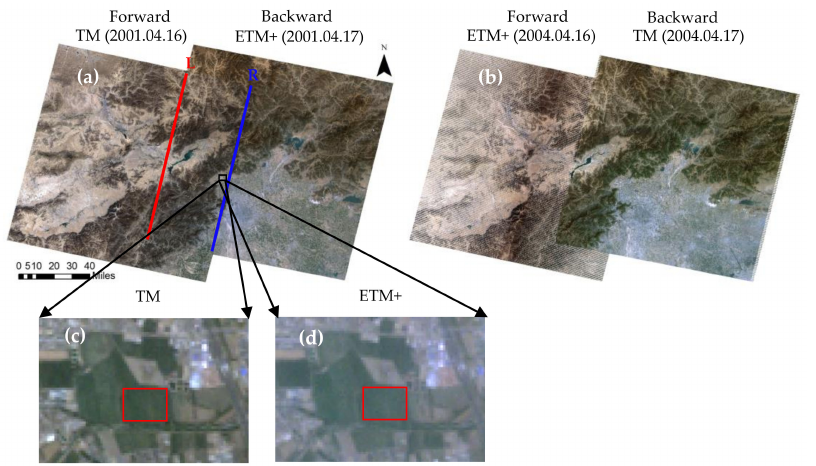
Figure 2. True color (red, green, and blue) combination of forward and backward observations collected by Landsat-5 TM and Landsat-7 ETM+ sensors with the sample area highlighted in the red squares ( c , d ); the acquisition dates of the left image pair ( a ) were 16 April 2001 (TM) and 17 April 2001 (ETM+), and 16 April 2004 (ETM+) and 17 April 2004 (TM) for the right side ( b